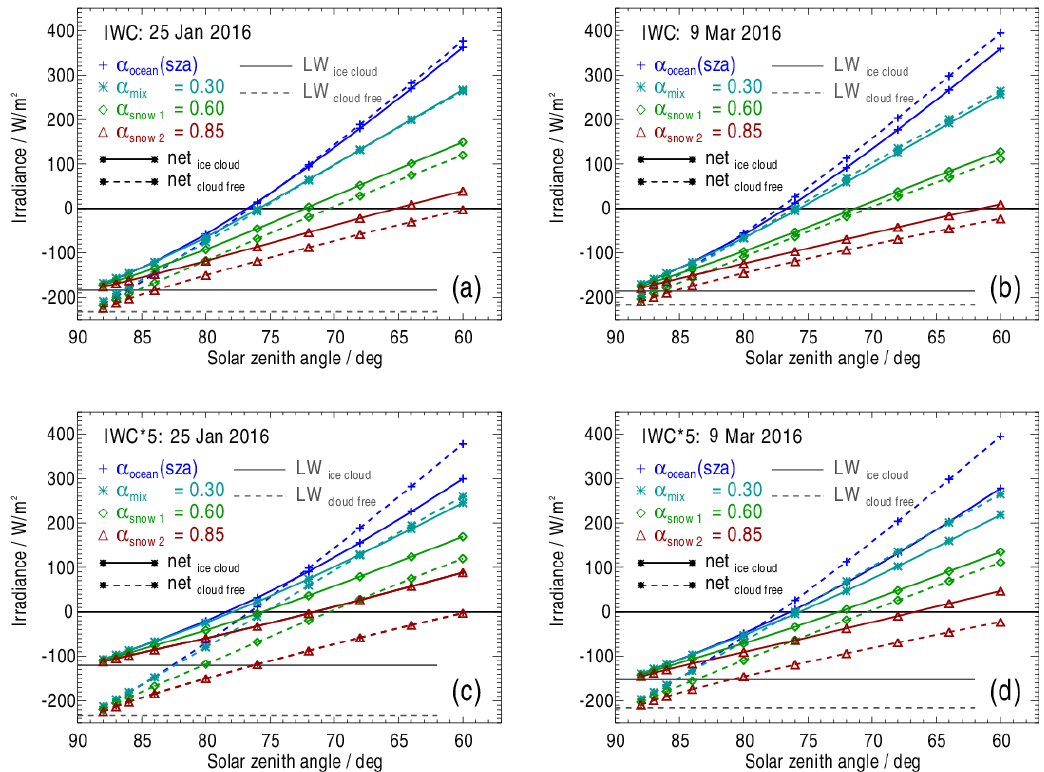
Figure 8. (a) Irradiance at the top of the atmosphere on 25 January 2016 as a function of solar zenith angle over an ice-free ocean, over snow-covered surfaces and over a mixed surface with albedo values as indicated. Panel (b) is the same as panel (a) but for the atmosphere on 9 March 2016. Solid curves show the atmosphere with an embedded ice cloud, whereas dashed curves show a cloud-free atmosphere. Panels (c) and (d) are the same as panels (a) and (b) respectively but for ice clouds with higher optical thicknesses obtained by multiplying the measured profile IWC( z ) by a factor of 5. Horizontal grey lines, valid for ε = 1 . 0, indicate the LW component of the irradiance.